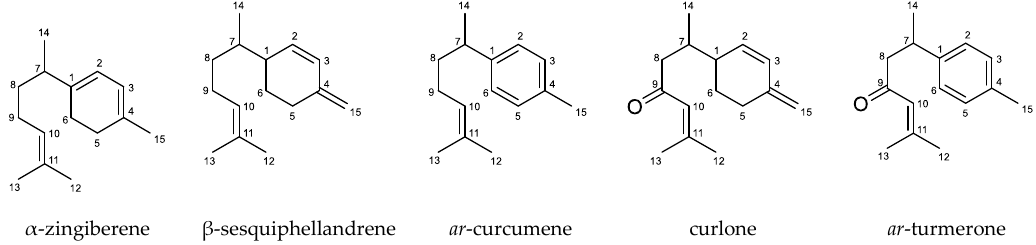
Figure 2. Chemical structures of five major compounds tested from C. longa EO. Table 3. Anti-trypanosomal activity and cytotoxicity of five pure compounds identified in C. longa EO.